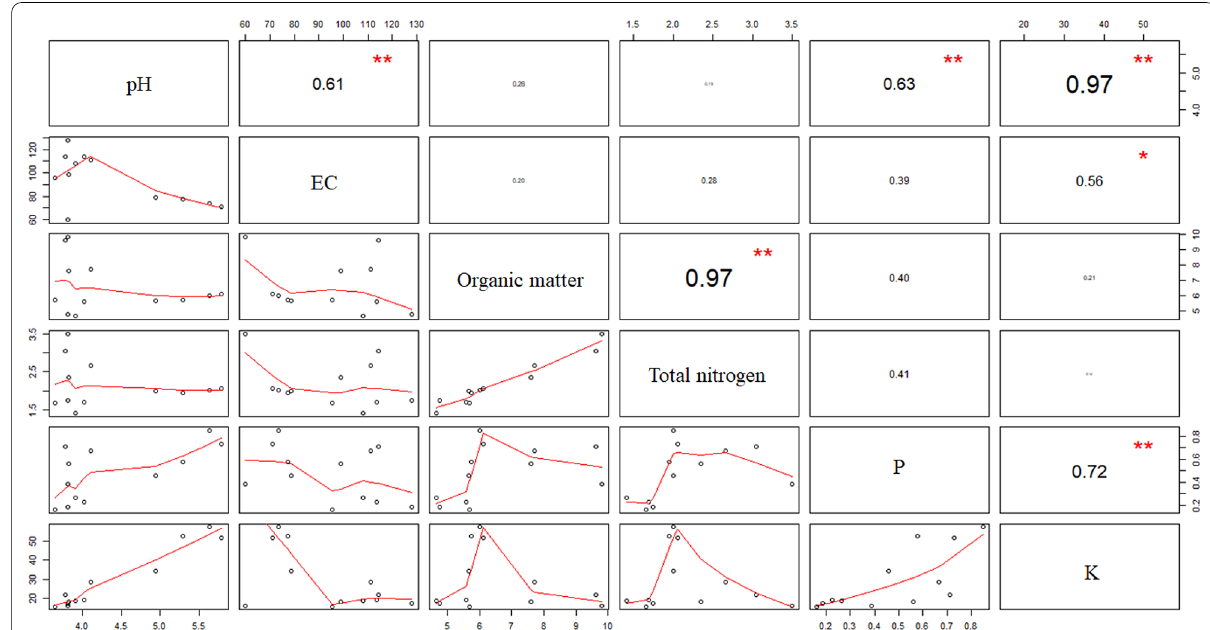
Fig. 3 Pearson correlation among the studied soil parameters. The closer the value is to 1, the higher correlation between the two variables are. Significance is indicated by **p‑value < 0.01, and *p‑value <